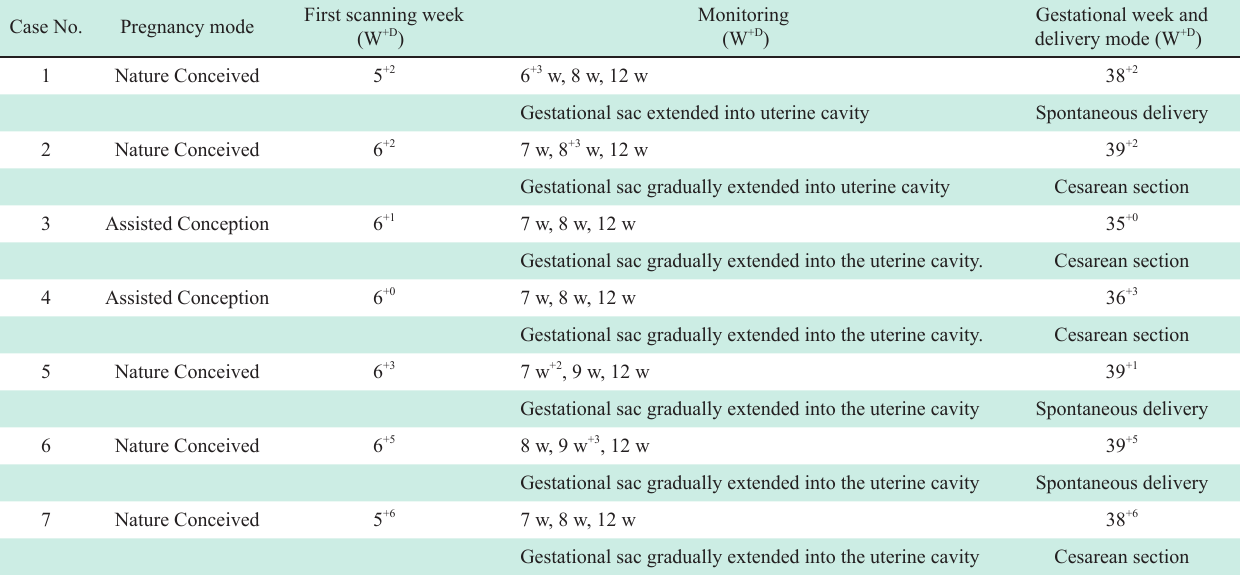
Table 2 The 7 cases of angular pregnancy converted to intrauterine pregnancy Case No.